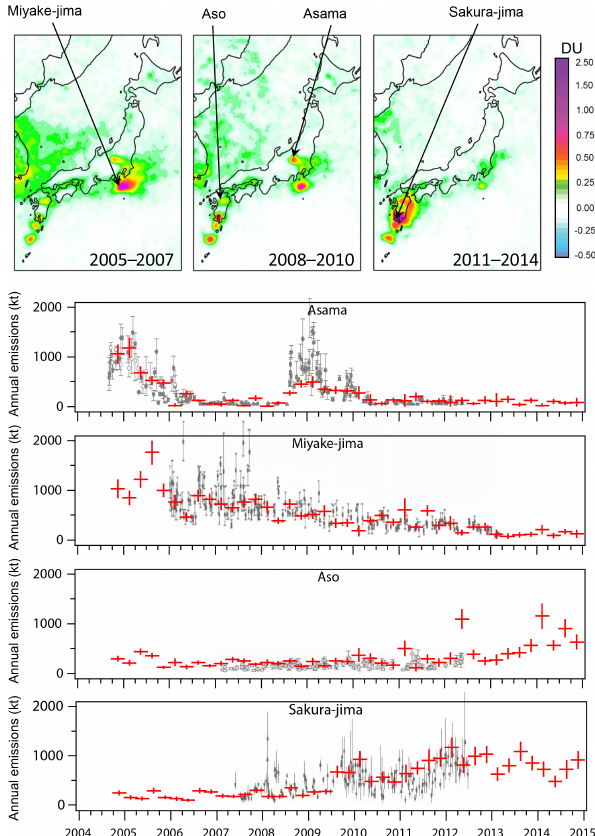
Figure 9. Top: maps of the mean SO 2 values for 2005–2007 and 2008–2010 over Japan. Bottom: time series of OMI-estimated an- nual emission rates calculated for every 3 months for four volcanoes are show in red. The error bars represent 2 σ confidence intervals. Grey dots are daily emission estimates provided by the Japan Me- teorological Agency. The grey vertical bars represent minimum and maximum